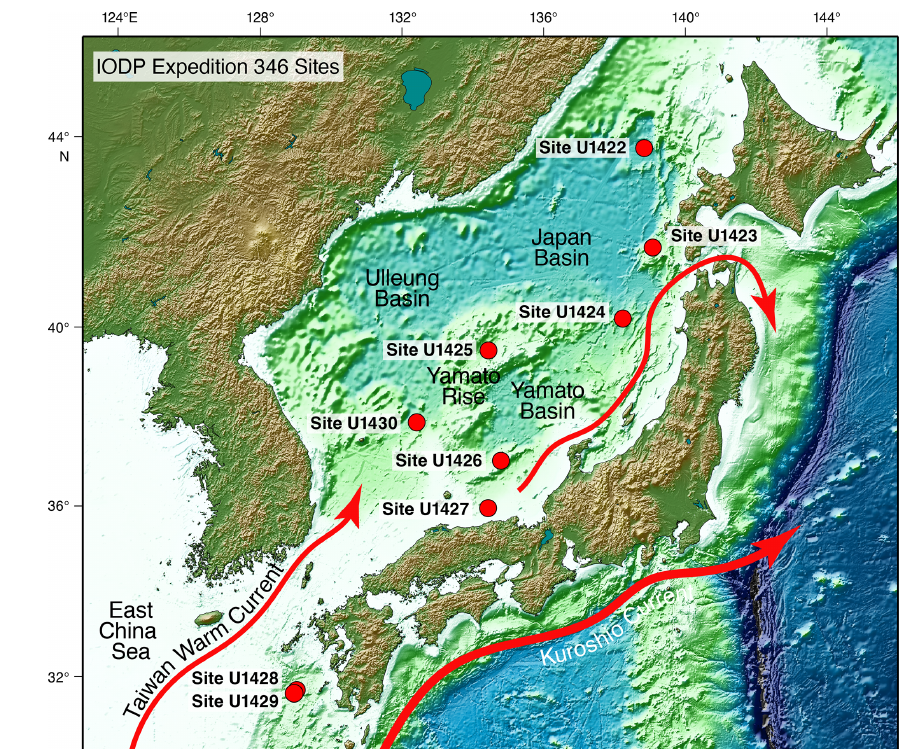
Figure 7. Bathymetric map of the area sampled by Expedition 346 with the major bathymetric features labeled as well as the locations of the drilling site. The red arrows show the major surface currents that affect the region. Modified after Tada et al.